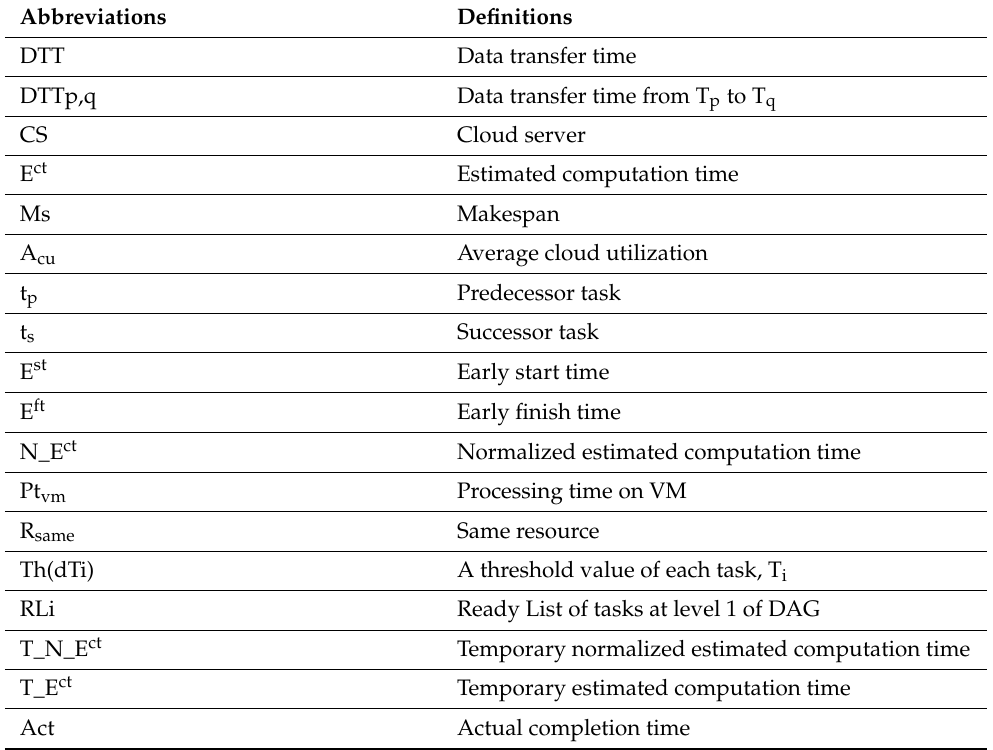
Table 2. List of